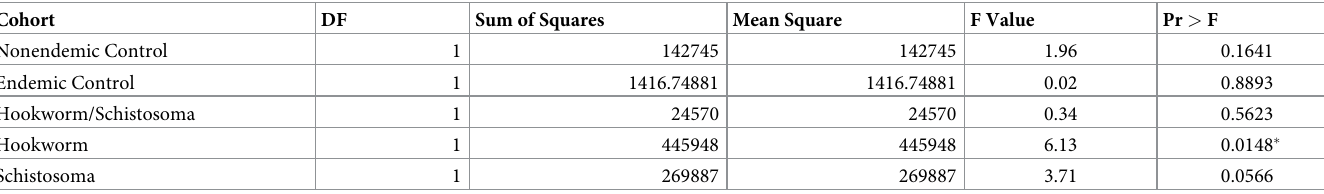
Table 2. Effect of sex within each cohort on TFF2 levels. Cohort